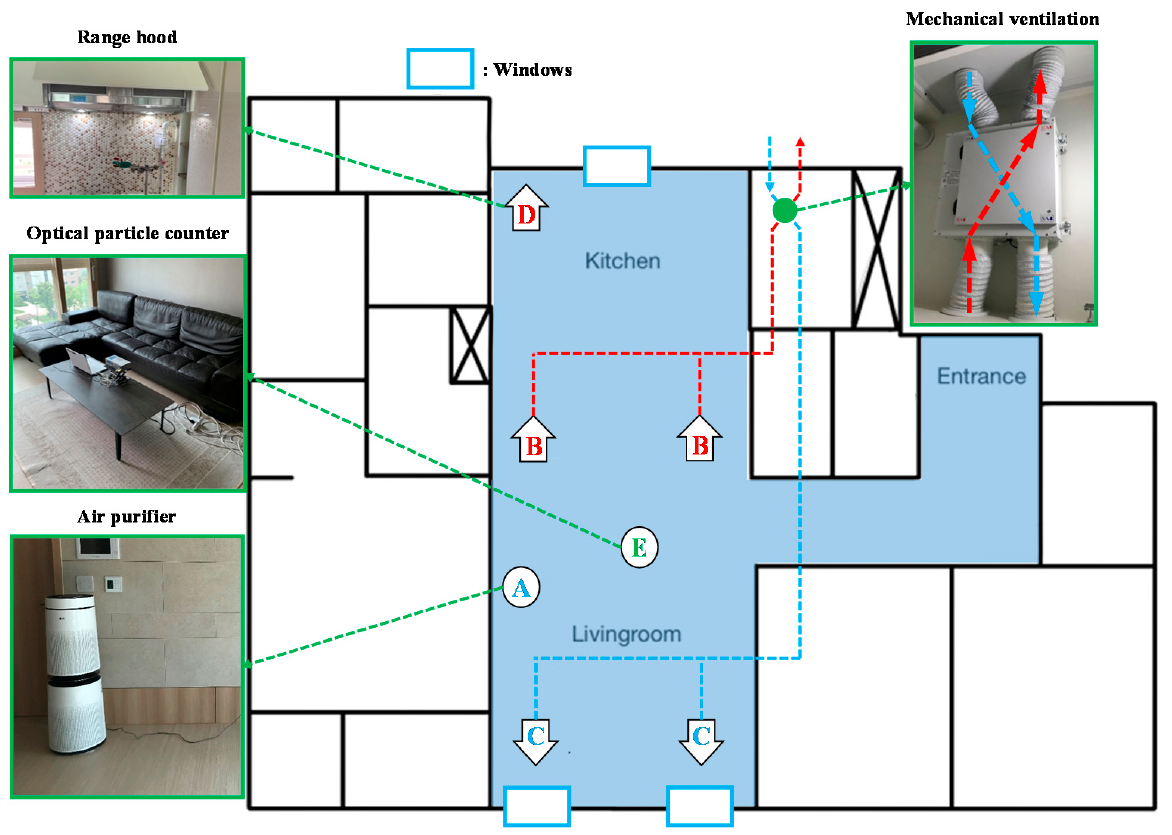
Figure 1. Apartment setup for experiments. Red letters and lines: IAQ management methods to exhaust indoor PM 2.5 . Blue letters and lines: IAQ management methods to supply outdoor PM 2.5 or clean indoor PM 2.5 .